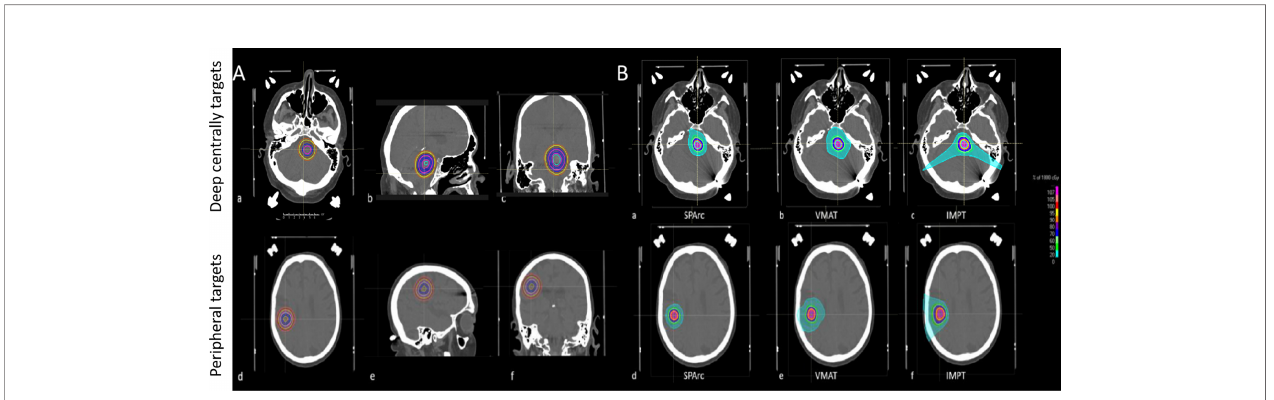
FIGURE 1 | (A) Target ’ s locations and sizes (from 0.3cc to 33.03cc) in the brain SRS dosimetric model. Deep centrally located targets (a, b, c); Peripheral targets (d, e, f). (B) A representative transverse view of dose distributions among SPArc, IMPT, and VMAT on the 0.3cc target. Deep centrally located 0.3cc target (a) SPArc, (b) VMAT, (c) IMPT; Peripheral 0.3cc target (d) SPArc, (e) VMAT, (f)